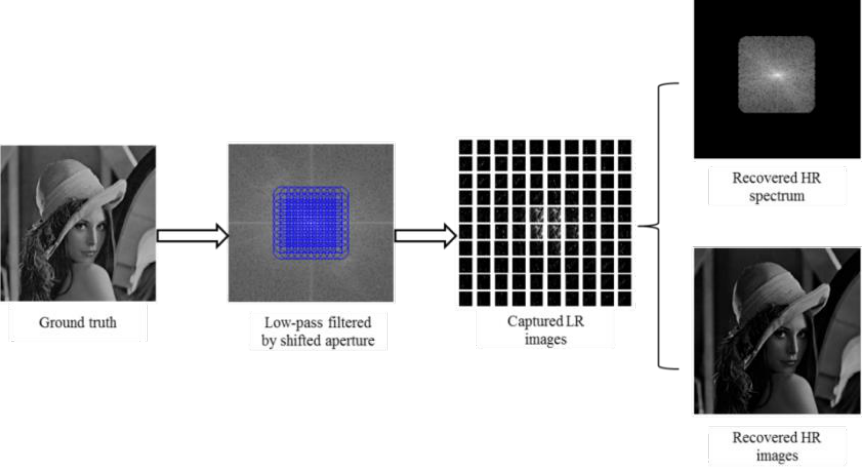
Figure 2. The imaging process of Fourier ptychography.